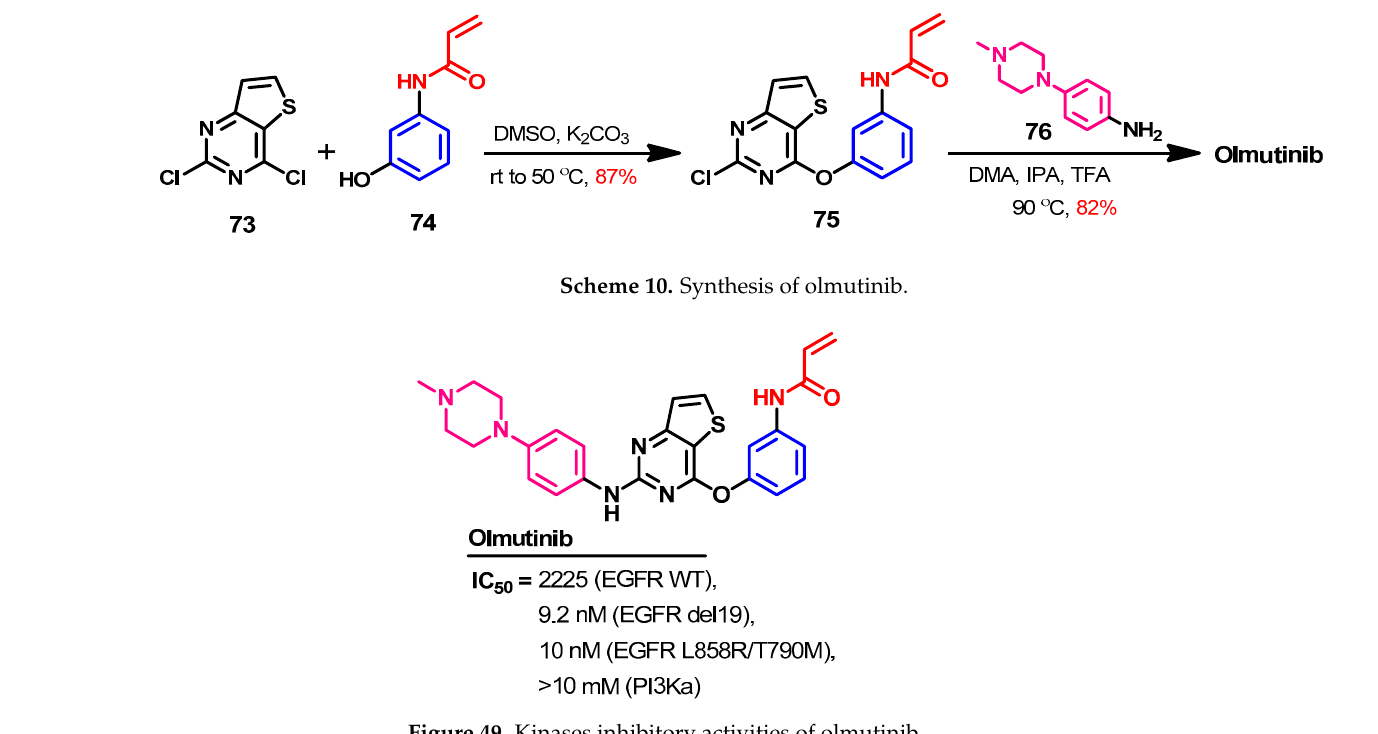
Figure 49. Kinases inhibitory activities of olmutinib.